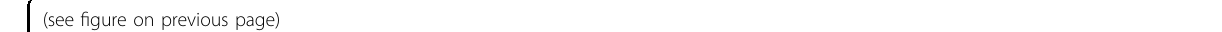
Fig. 4 High expression of meCAF markers in the stroma predicts poor prognosis in patients with PDAC. a Higher expression of four meCAF marker genes ( PLA2G2A, CRABP2, SERPINE2, and MFAP5 ) predicting a worse overall survival (OS) in patients with PDAC (TCGA PAAD database, n = 178). b Representative H&E and IHC stainings of meCAF markers (PLA2G2A and CRABP2) indicated high expression of these markers in loose-type PDAC ( n = 94). High expression of meCAF markers (PLA2G2A + CRABP2) in the stroma predicted a poor OS in patients with PDAC ( n = 76). c Representative IHC staining of myCAF marker (POSTN) indicated its high expression in dense stroma of PDAC ( n = 94). The expression level of POSTN in stroma showed no correlation with OS of PDAC patients ( n = 76). d – f Representative IHC staining of an iCAF marker (APOD) and CAF subcluster 1 and 2 markers (RGS5 and MYH11). The expression of these markers show no correlation with the overall survival in patients with PDACs. Scale bar, 100 μ m. Censored samples are indicated by “ + ” . Kaplan – Meier curve was used for survival analysis. All statistical analyses were performed with the Log- rank